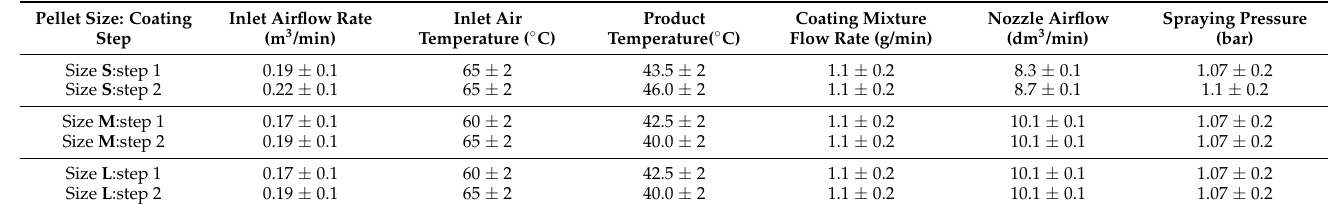
Table 1. Coating process